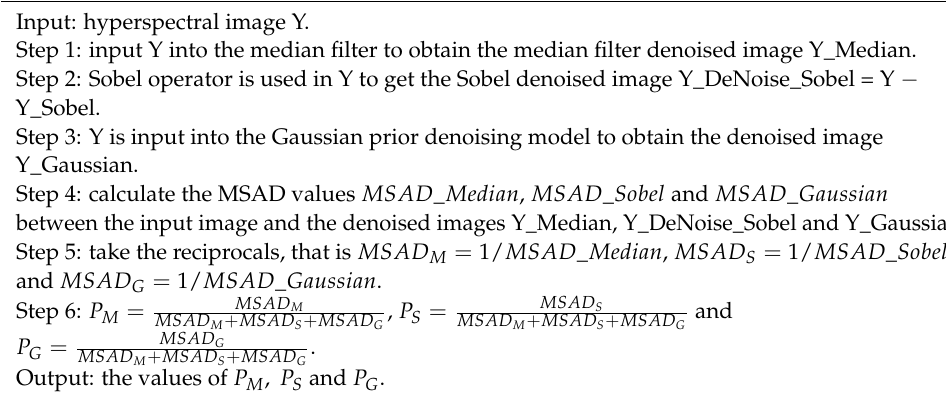
Algorithm 1. The procedure of determining P M , P S and P G in